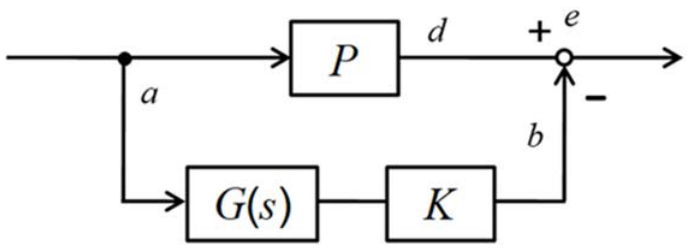
Figure 4. Block diagram of the All ‐ pass filter.